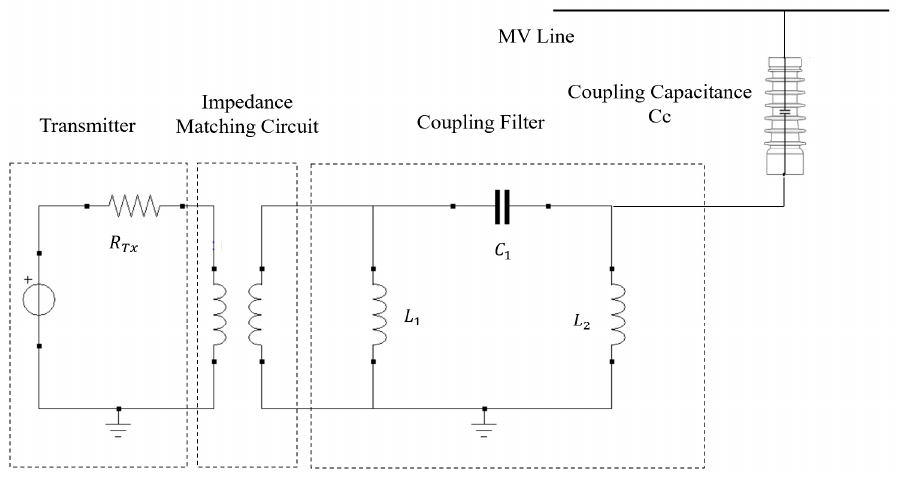
Figure 4. Main characteristics of the coupling system with MV network.